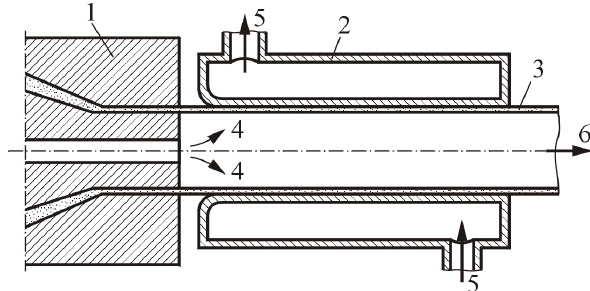
Figure 2: Outside calibration;